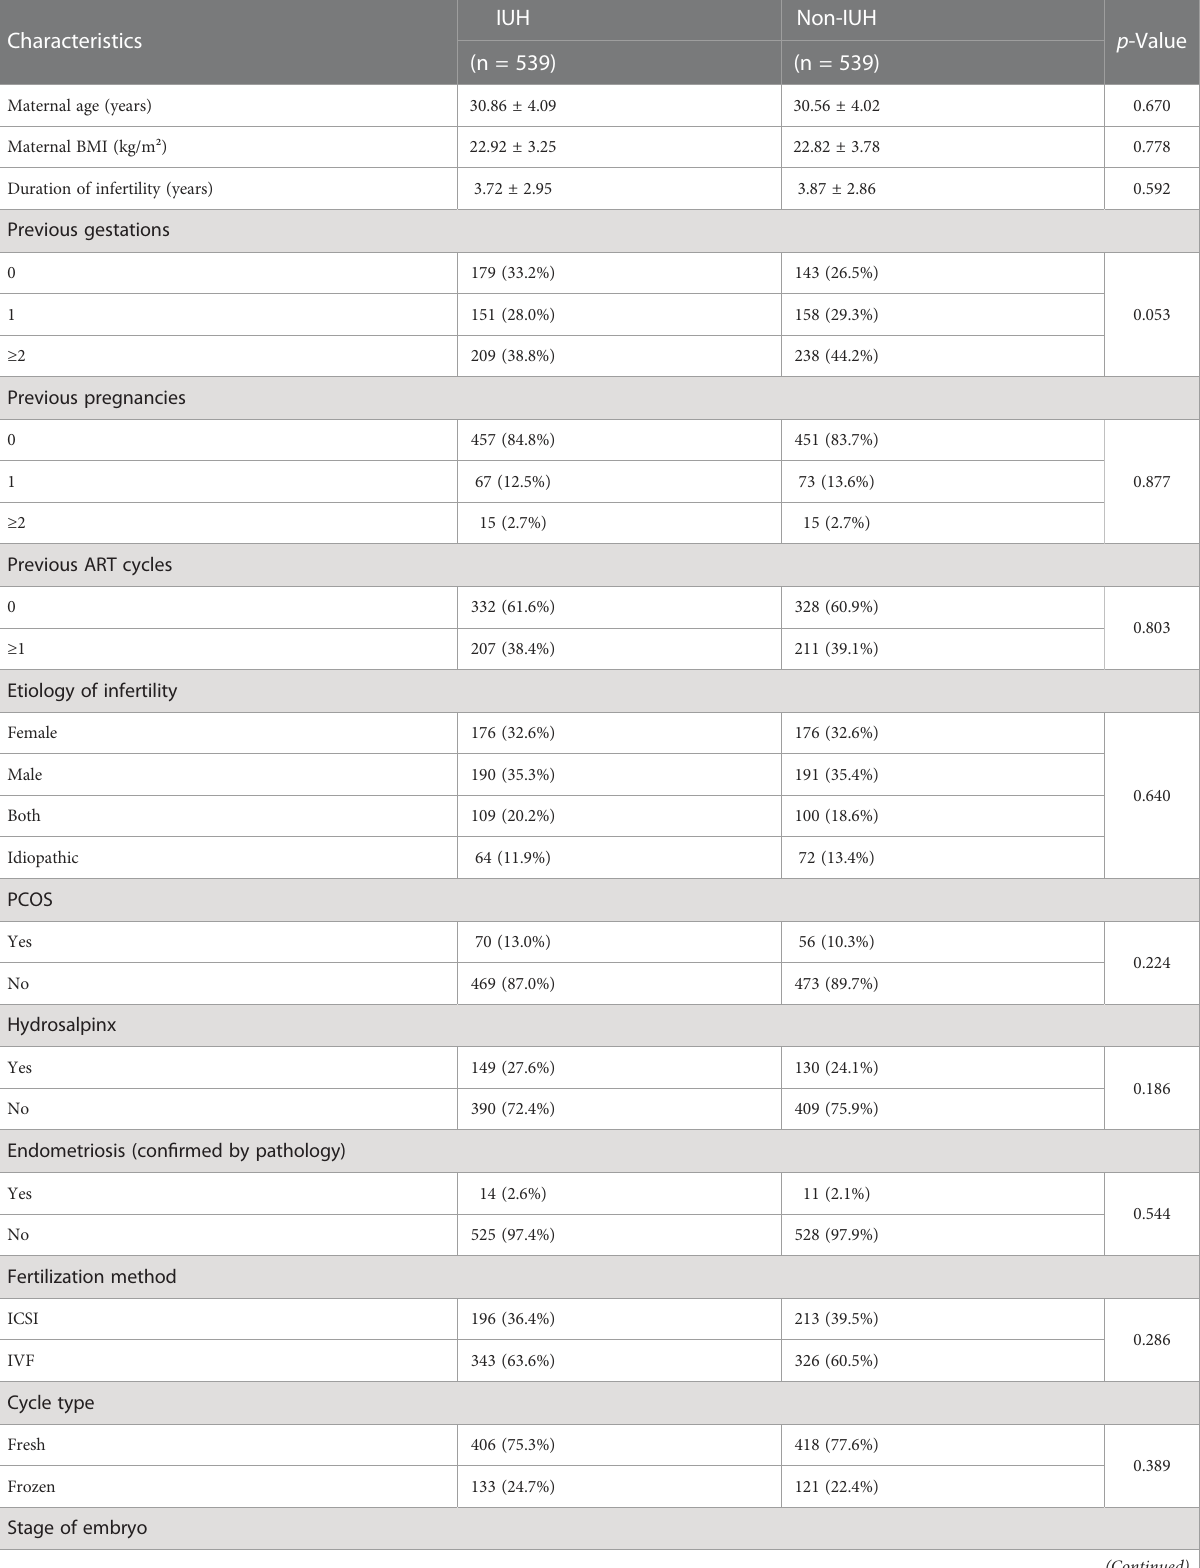
TABLE 1 Demographic characteristics and clinical information in patients with and without intrauterine